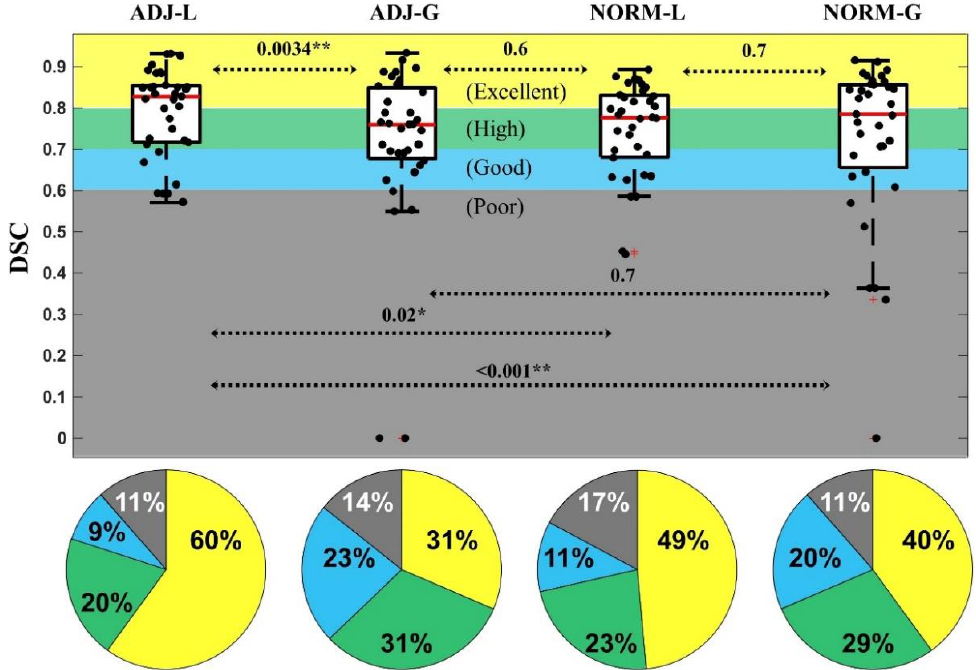
Figure 5. DSC for the best-performing pipeline of each standardization method. Pies indicate the percentage of patients with excellent similarity (yellow, DSC > 0.8%), high similarity (green, DSC from 0.7 to 0.8), good similarity (blue, DSC from 0.6 to 0.7), and poor similarity (DSC < 0.6). Significant differences (Wilcoxon signed-rank test) between the standardization methods are indicated with asterisks (* p < 0.05; ** p < 0.01). Data points beyond the boxplot whiskers are indicated with